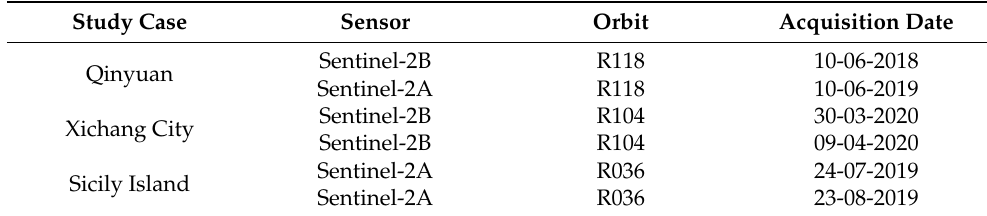
Table 2. Data parameters and